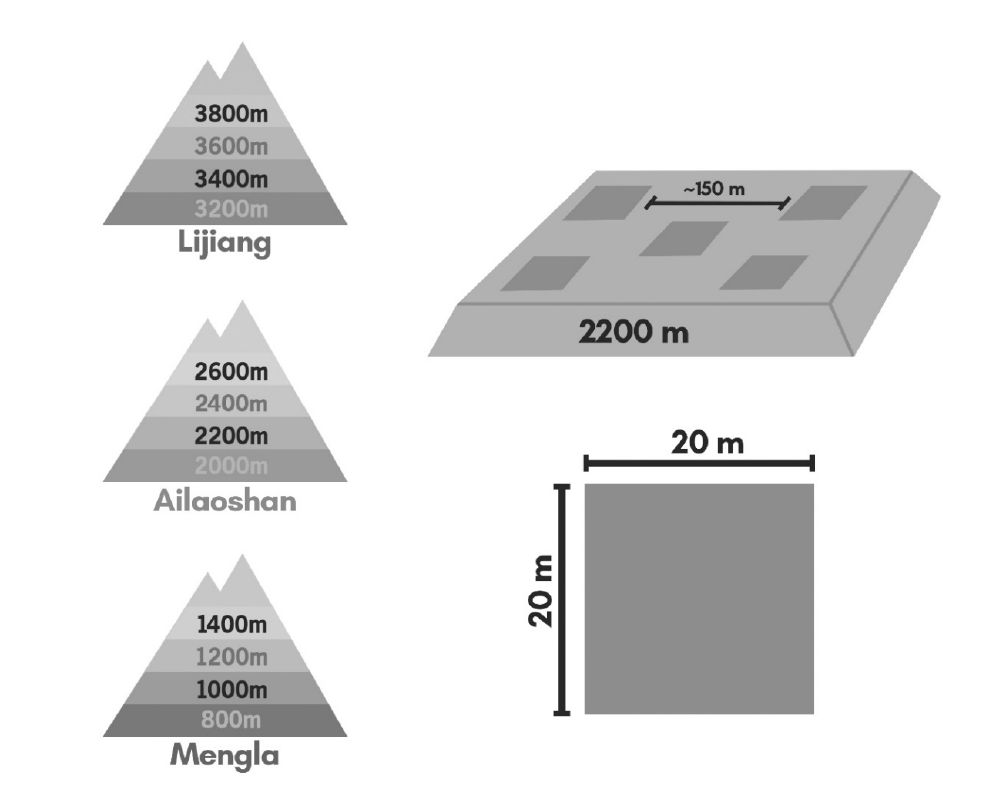
Figure A1. Schematic diagram of our study design, showing the elevational bands of the three transects (viz. Lijiang, Ailaoshan and Mengla; left), the distances between study plots within each elevational band, and the dimensions of each plot (bottom right). Distances are not to scale, and the precise spatial arrangement of study plots varied across elevations and transects depending on the available habitat.